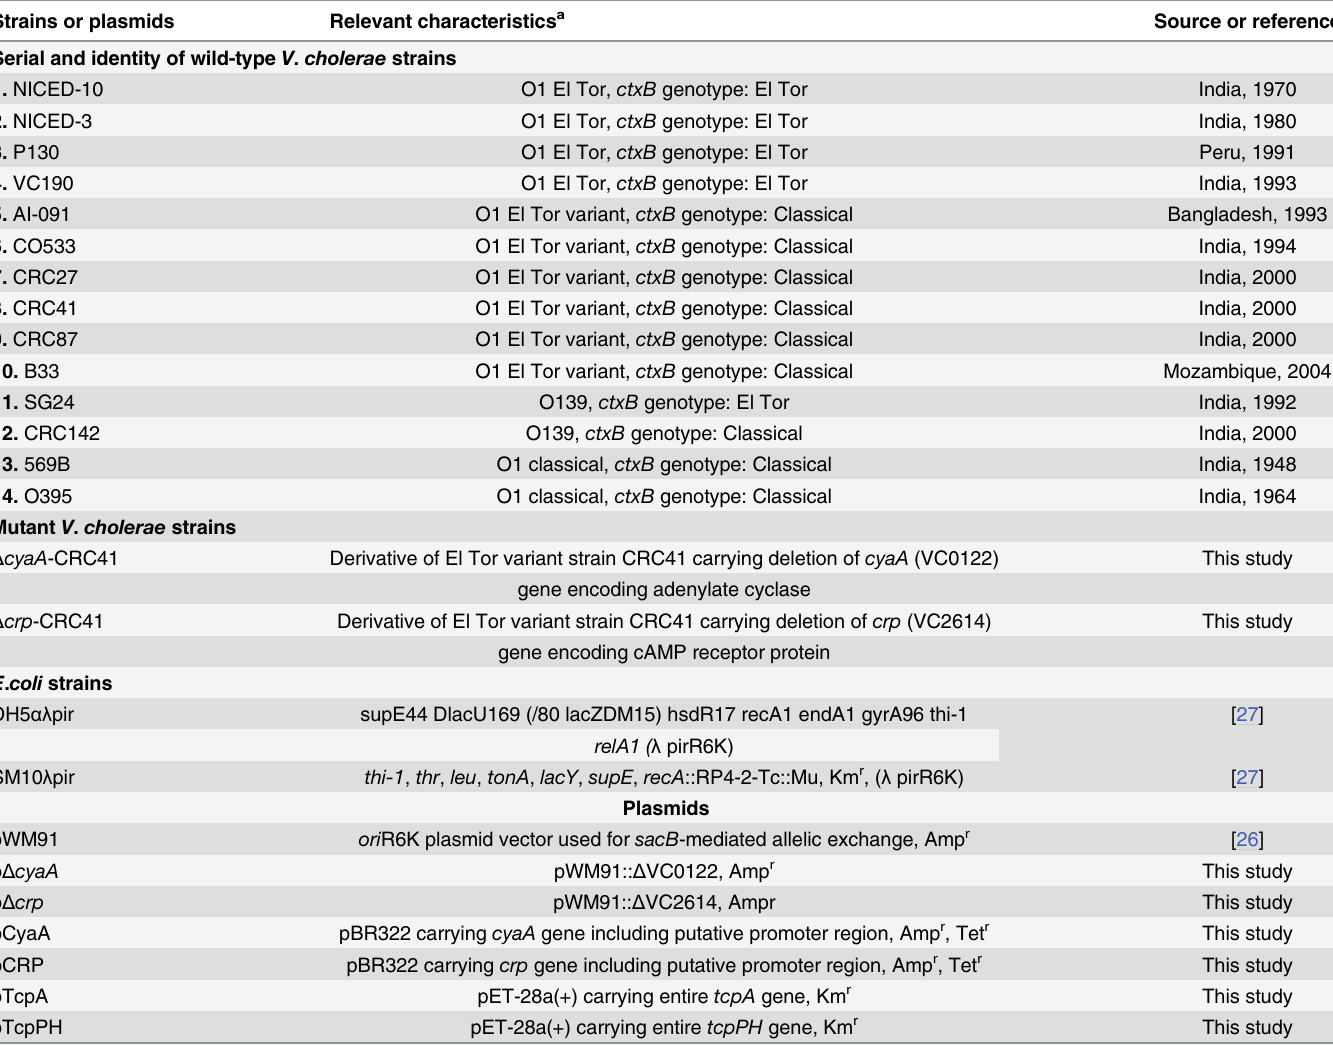
Table 1. Bacterial strains and plasmids used in this study. Strains or